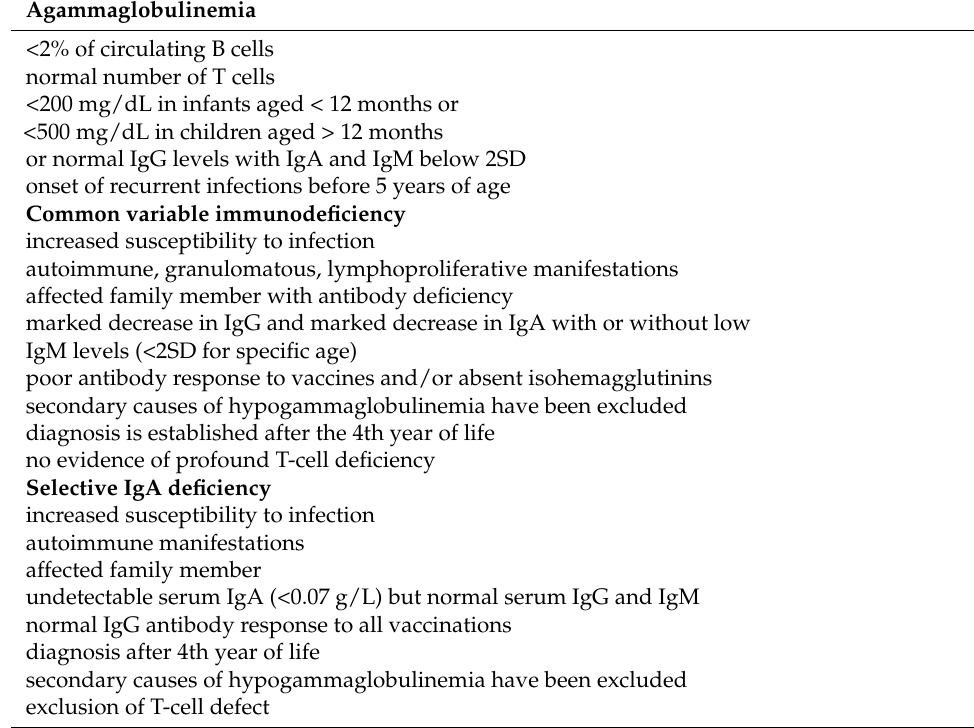
Table 3. Diagnostic criteria of European Society for Immunodeficiency (ESID) for agammaglobuline- mia, common variable immunodeficiency, selective IgA deficiency